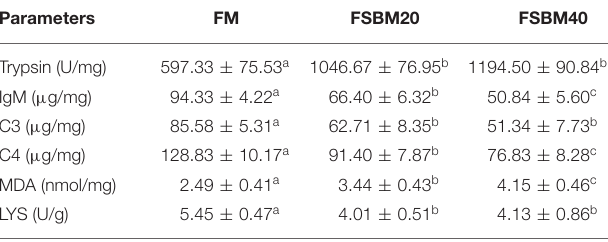
TABLE 6 | Effect of different levels of fermented soybean meal substitute for fish meal protein on the enzyme activities of pearl gentian grouper ( n = 3). Parameters